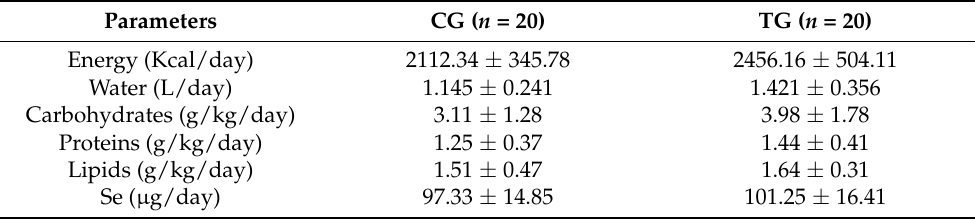
Table 2. Nutritional intakes of participants.